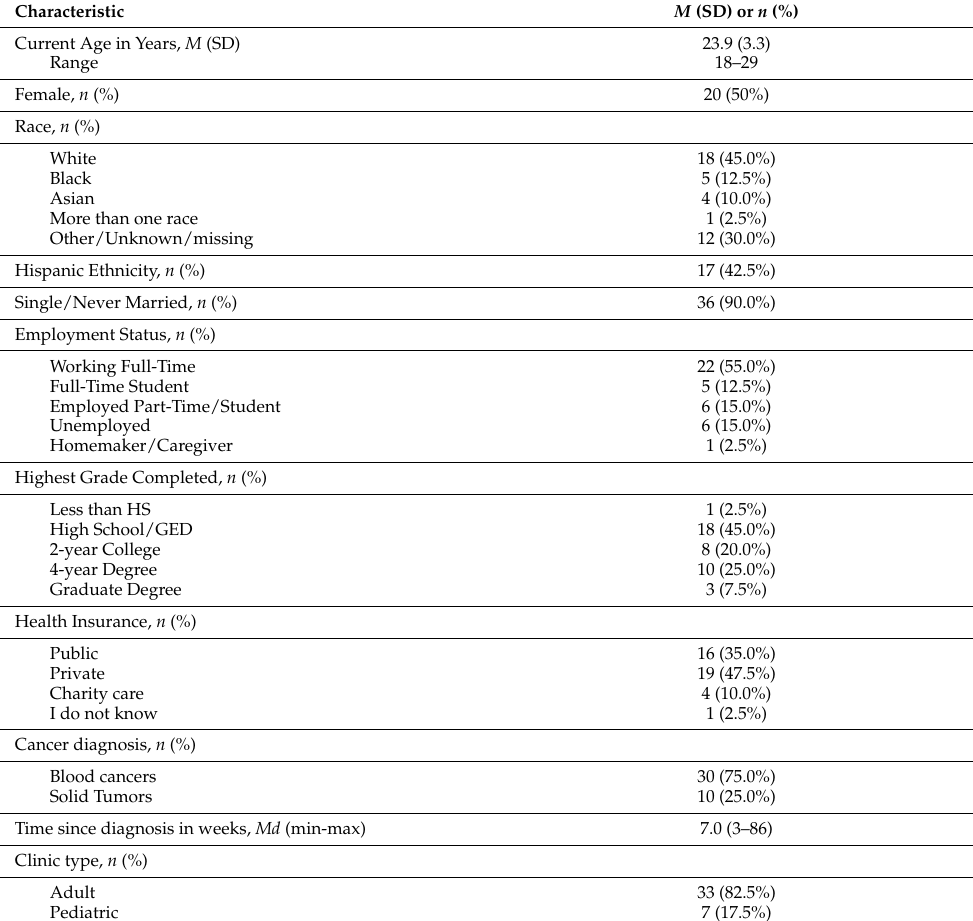
Table 1. Participant Characteristics ( n =